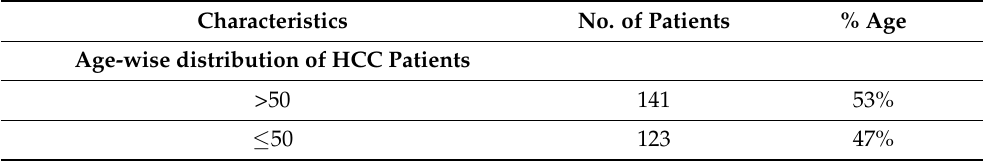
Table 1. Clinical features of 264 Pakistani HCC patients. Characteristics No. of Patients Age-wise distribution of HCC